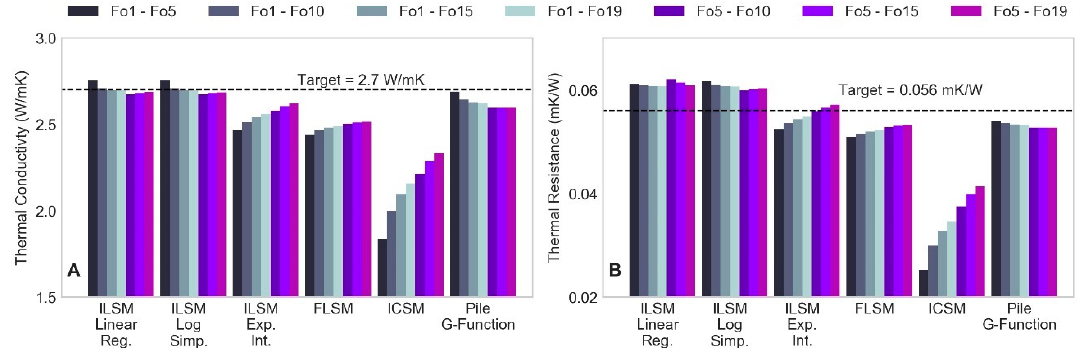
Figure 11. Comparison between analytical models results for ( A ) thermal conductivity and ( B ) pile thermal resistance over seven different fitting regions bounded by the Fourier times shown.